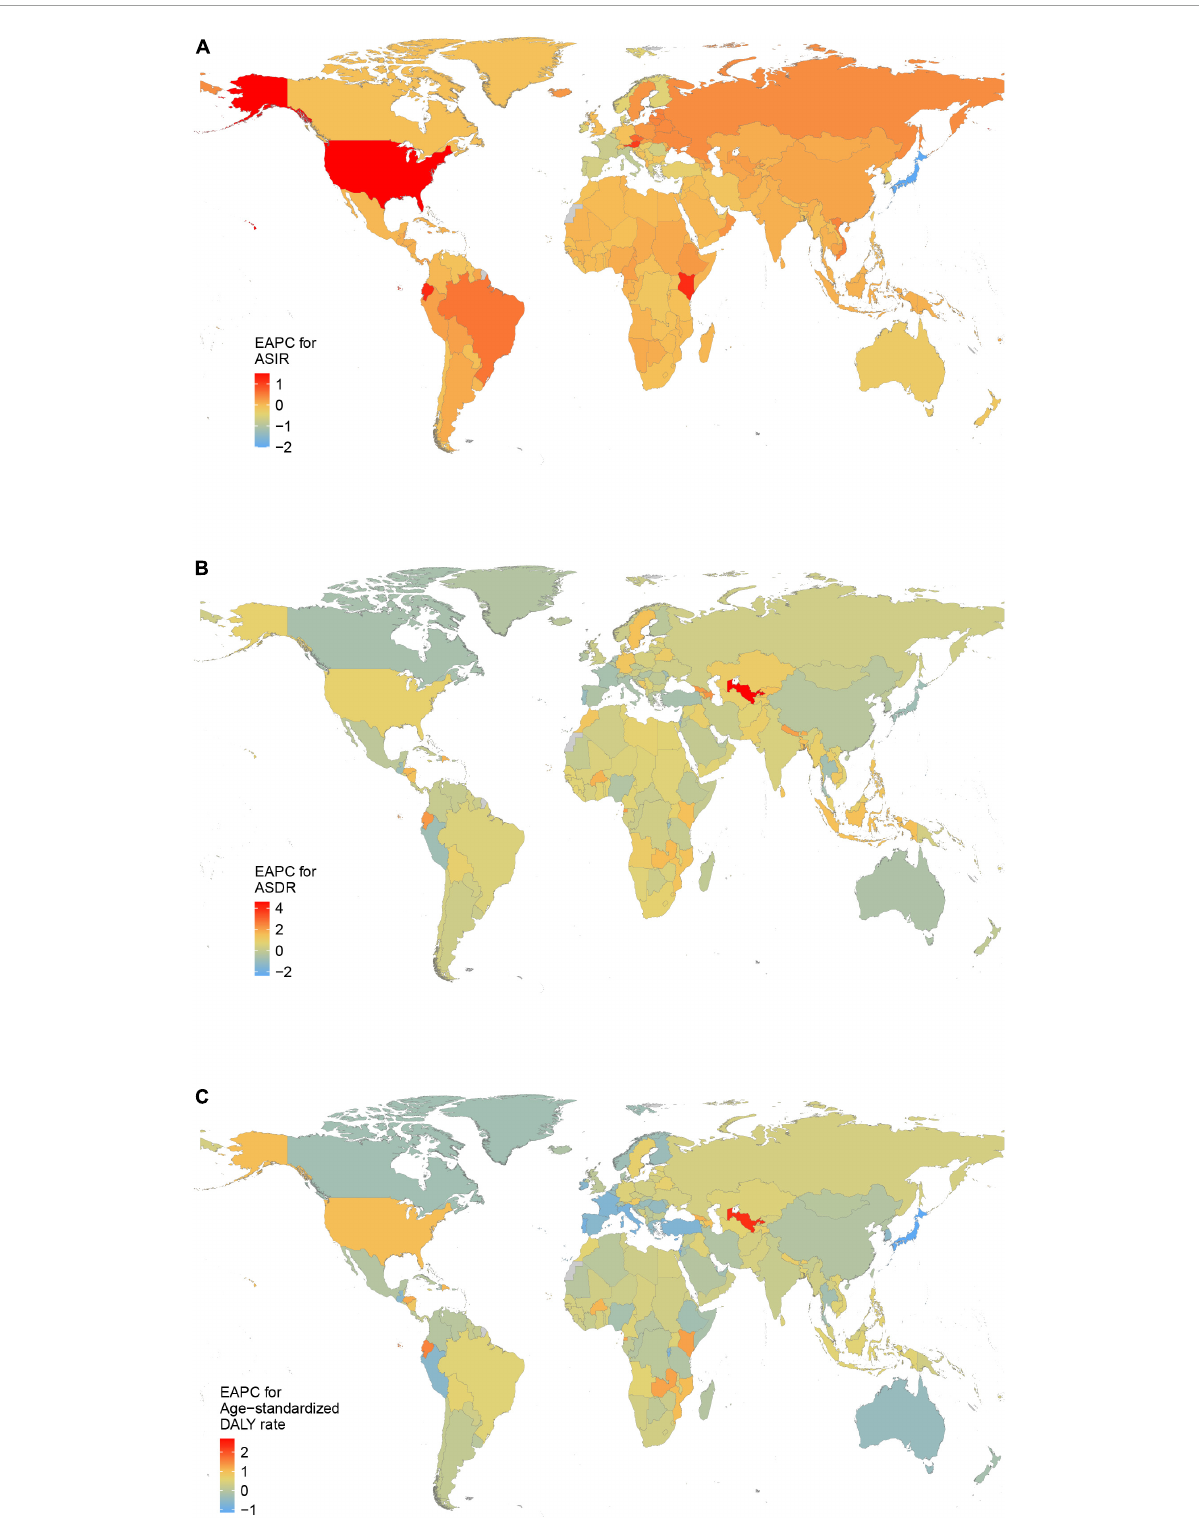
FIGURE3 The estimated annual percentage change (EAPC) of atrial fibrillation in 204 countries and territories between 1990 and 2019. (A) The EAPC of age-standardized incidence rate (ASIR). (B) The EAPC of age- standardized death rate (ASDR). (C) The EAPC of age-standardized disability-adjusted life-year (DALY)